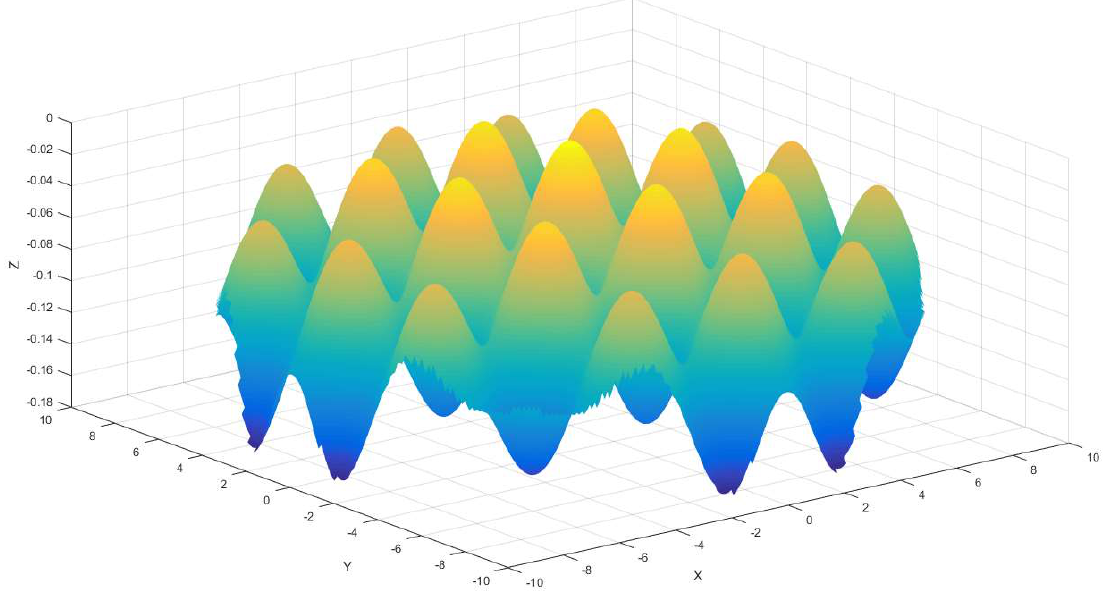
Figure 4. Compound sinusoidal grid surface.